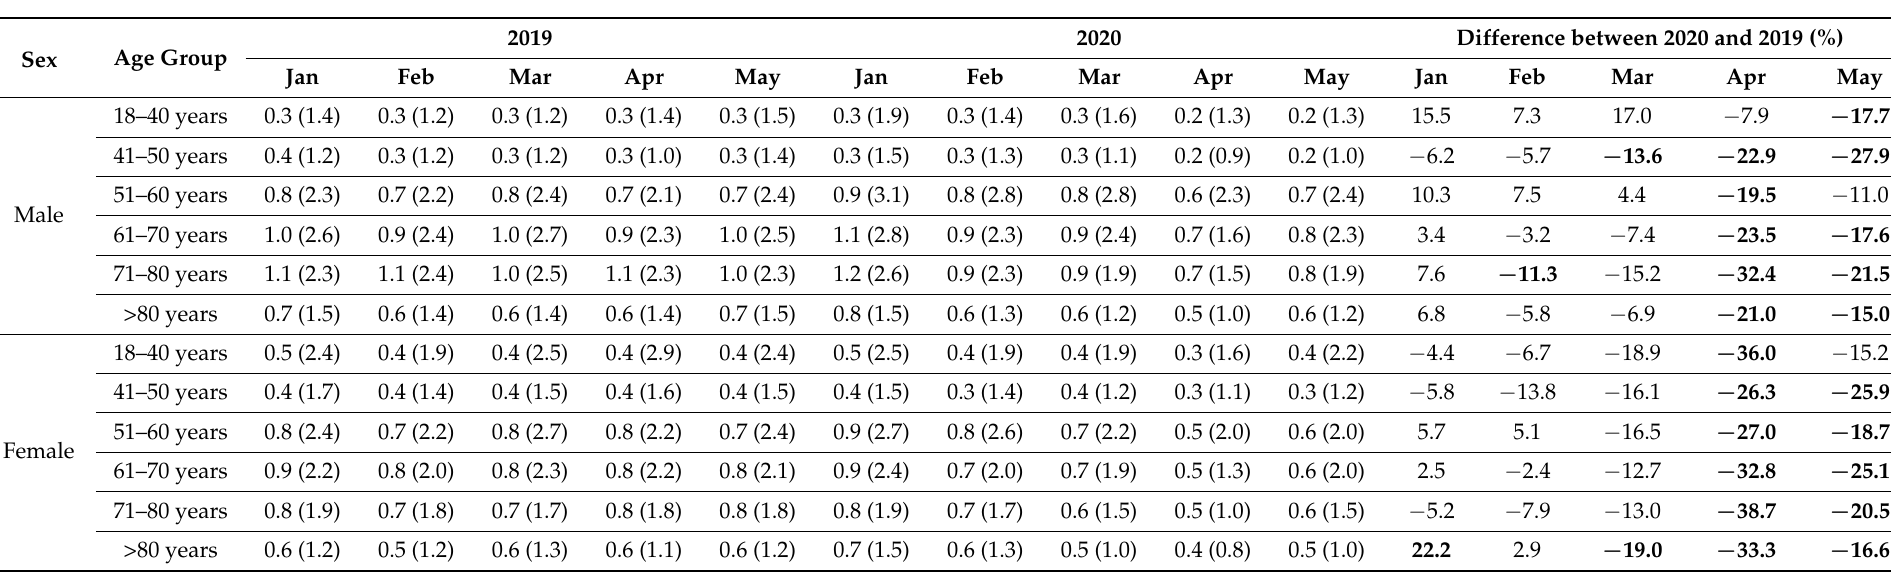
Table 2. Differences by sex and age in the number of new cancer diagnoses per practice in Germany between January and May 2020 and January and May 2019. Sex Age